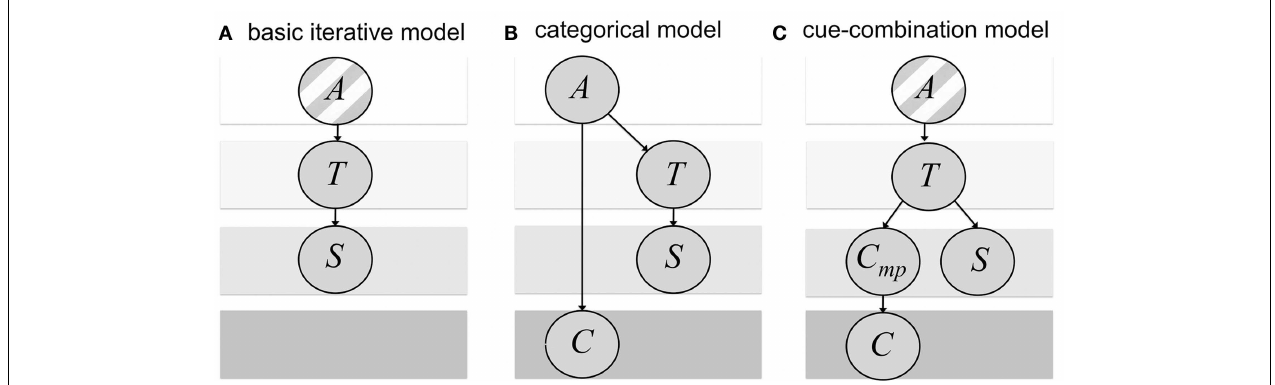
underlying category A . Again, the stimulus S is a noisy measurement of the target distance T . (C) Cue-combination model:The stimulus S and cue signal C mp represent both independent noisy measurements of the target distance T that is drawn from a single underlying category A .The cue signal C mp is mapped to the symbolic cue C .The striped background in (A,C) indicates that T is assumed to be drawn from a single category A in contrast to (B) were target distance and cue depend on the choice of the underlying category.